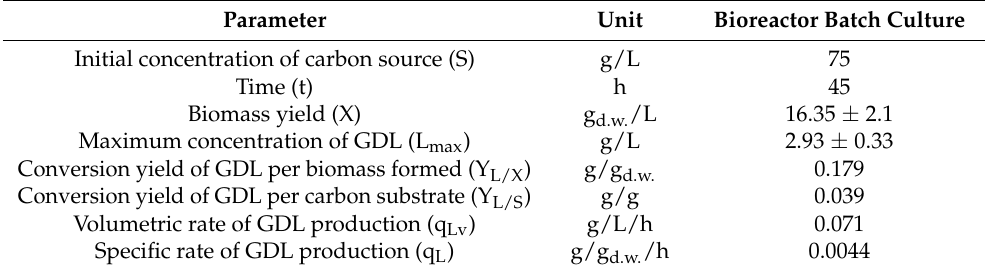
Table 5. Kinetic parameters of γ -decalactone biosynthesis in a bioreactor batch culture of Y. lipolytica , according to the parameters in Table 4, determined on the basis of the Taguchi